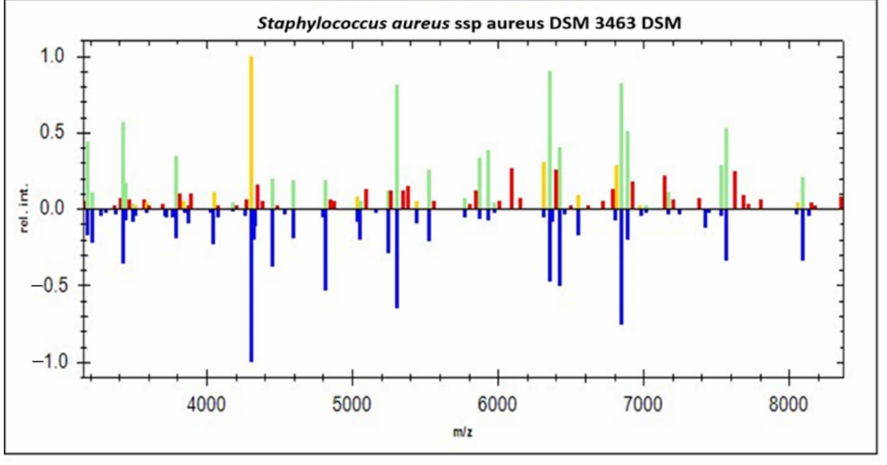
Figure 1. Comparison of the spectral protein profiles of 48 Staphylococcus aureus recovered from chilled ground meat samples with those of Staphylococcus aureus subspecies. aureus DSM 3463 as a reference strain using Compass Satellite Software. Blue color in the lower part of the spectra shows the deposited spectra used for matching patterns; green color in the upper part of the spectra shows excellent matched peaks, whereas red and yellow colors show mismatched and intermediate peaks, respectively.